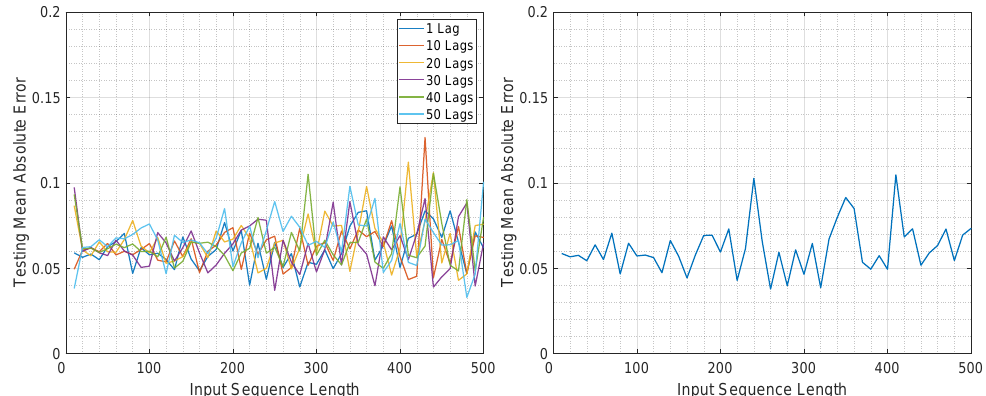
Figure 5. Illustration of the testing mean absolute error value for Experiment 1, LSTMTF ( left ) and VLSTM ( right ), using a many-to-one prediction mode.